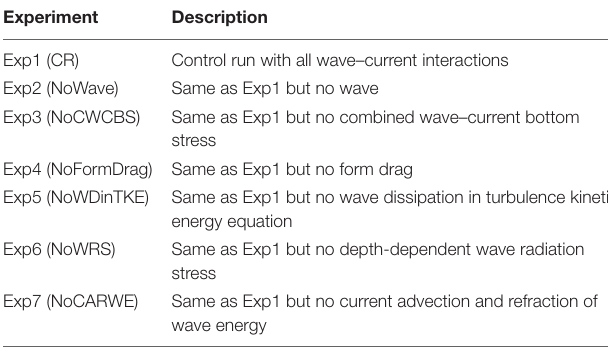
TABLE 1 | Summary of experiment